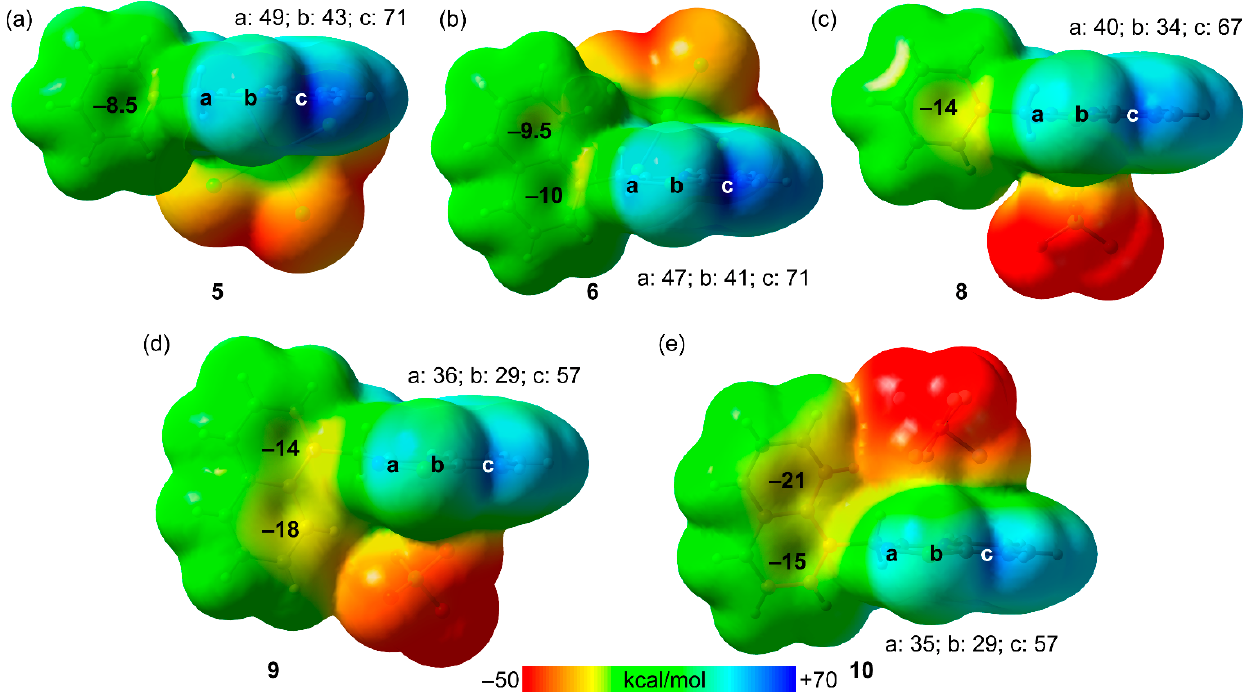
Figure 3. MEP surfaces of compounds 5 ( a ), 6 ( b ), 8 ( c ), 9 ( d ), and 10 ( e ) at the PBE0-D3/def2-TZVP level of theory. The values at selected points of the surfaces are given in kcal/mol.